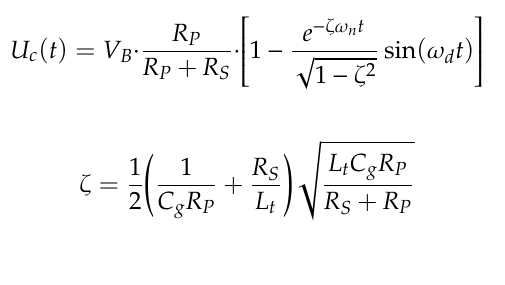
3 , N 4 , and U error